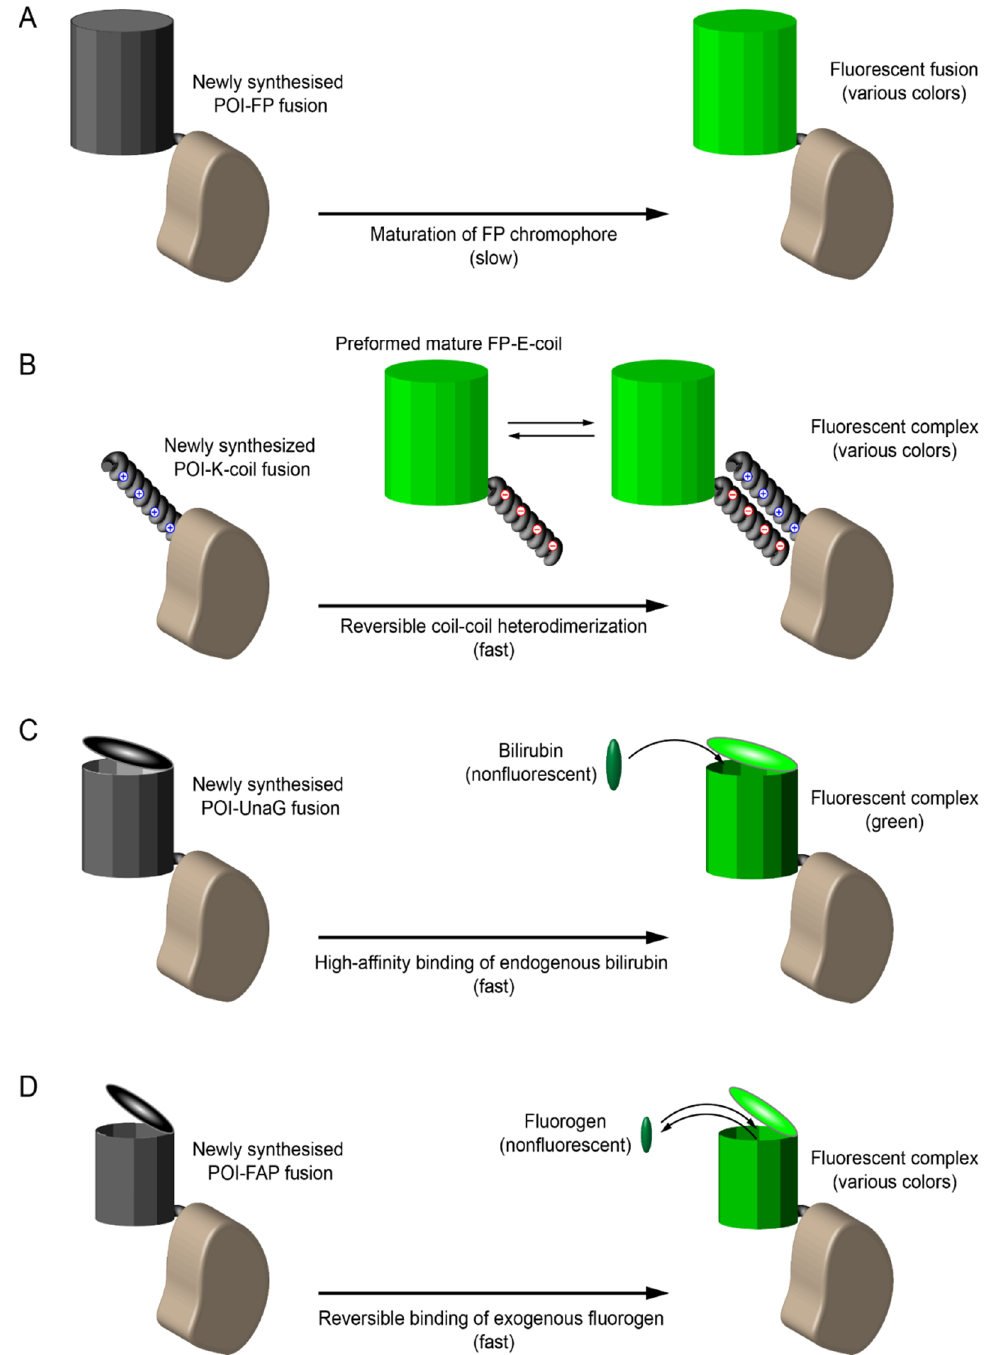
Figure 4. Different strategies of genetic tagging. Protein of interest (POI, brown) can be fused with various tags to ensure fluorescence labeling in live cells. ( A ) Classical labeling with GFP-like fluorescent proteins (FP). Chromophore maturation in FP is a relatively slow process (tens of minutes), thus early events of POI trafficking and interactions are missed. This problem can be solved by immediate labeling of newly synthesized POI with tags depicted in B – D . ( B ) KECs labeling. A heterodimerizing pair of coils (positively charged K-coil and negatively charged E-coil) is used to attract preformed mature FP to nascent POI. It can be applied to POIs with distinct intracellular localization (fibers, membranes, etc.) to distinguish between target signal and diffuse FP background. ( C ) Labeling with bilirubin-binding fluorescent protein UnaG. ( D ) Labeling with fluorogen-activating proteins (FAP), which bind exogenously added fluorogenic dyes.